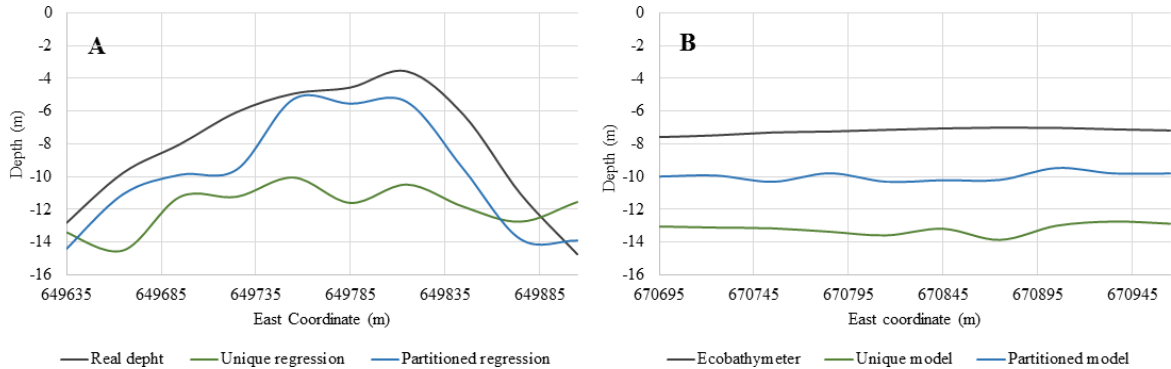
Figure 3. Profiles spaced by 30 m extracted by the ecobathymeter, the single model and the partitioned